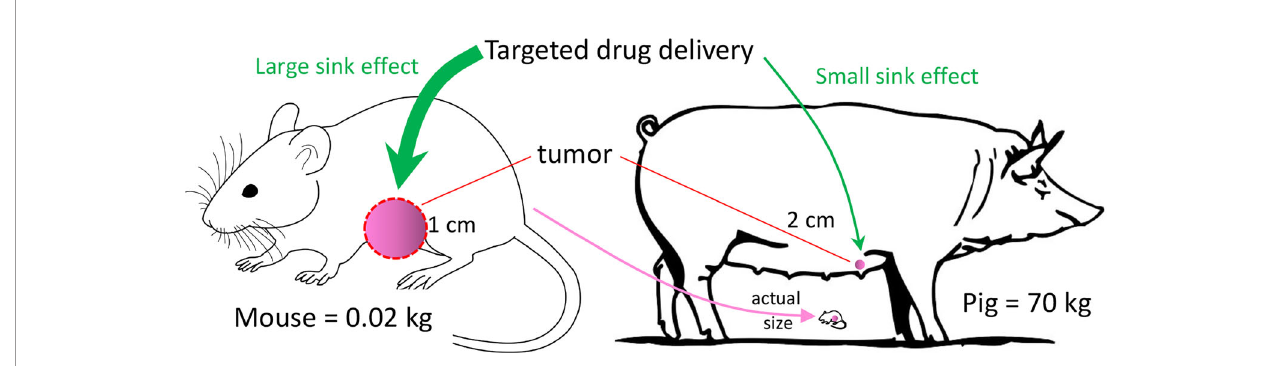
FIGURE 1 | Tumor Sink. In this example, murine tumor:body mass ratio is 400x the porcine ratio, even though murine tumor mass is only ~12% that of the porcine tumor. If a targeted drug preferentially concentrates in the tumor (i.e., tumor sink), then a given drug dose in the mouse may have a relatively high concentration in the tumor with respect to the plasma. The effect of tumor sink on plasma concentration at the same dose in the pig would be negligible because of the large body size. Thus, the same dose in the pig would produce a higher plasma concentration, possibly producing greater systemic toxicity than in the